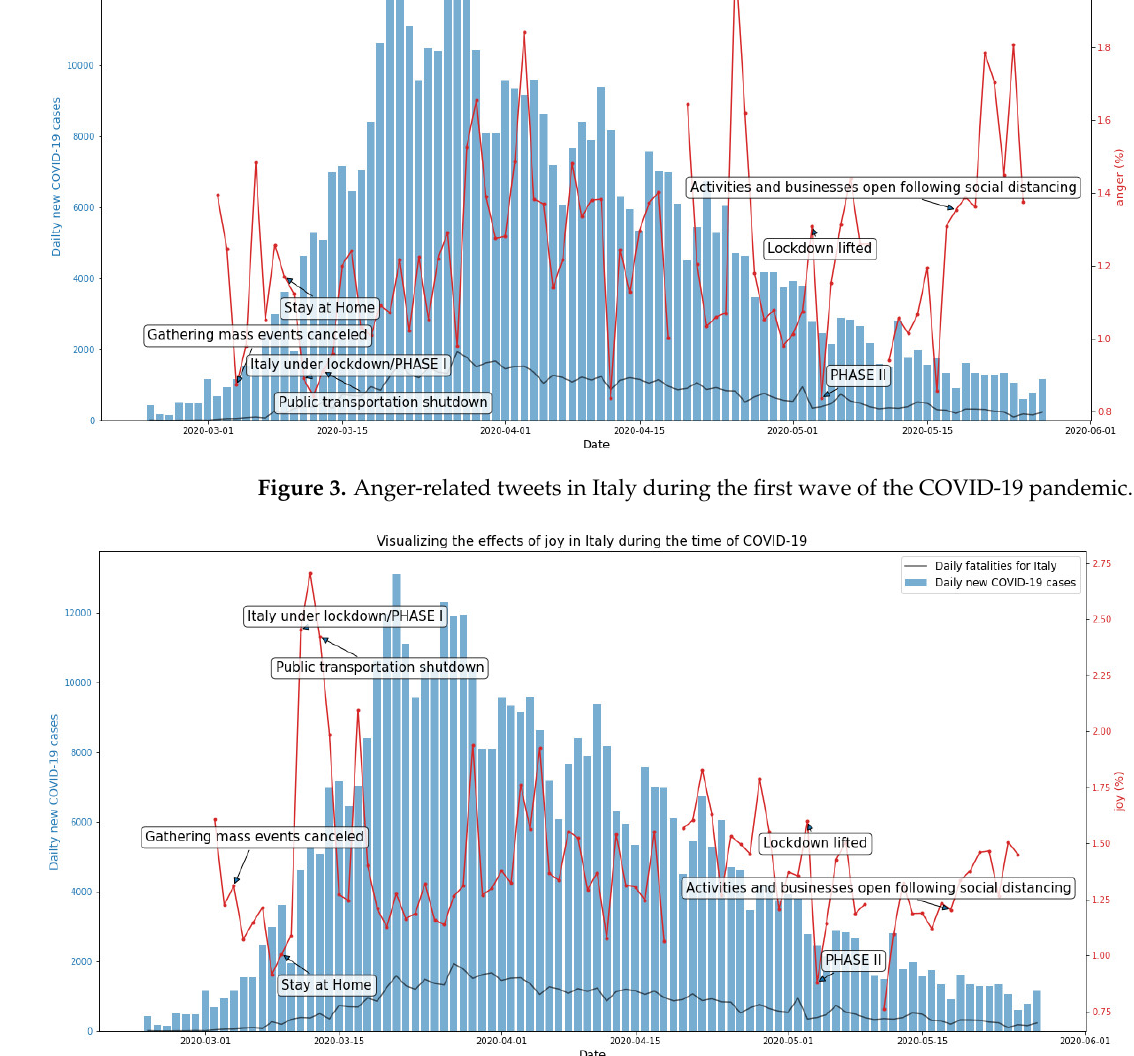
Figure 4. Joy-related tweets in Italy during the first wave of the COVID-19 pandemic.